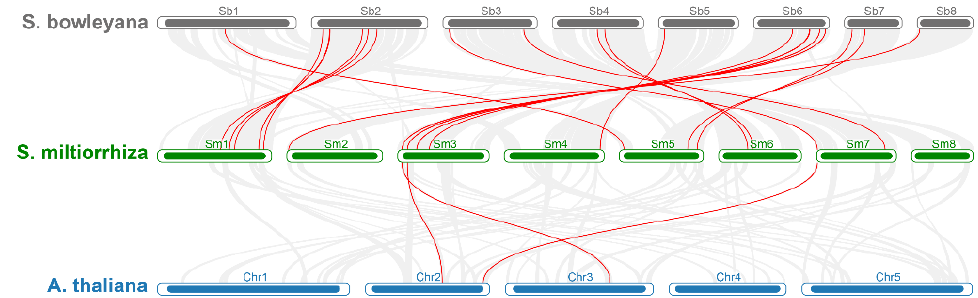
Figure 3. Synteny analysis of GATA genes within S. miltiorrhiza , A. thaliana , and S. bowleyan a. Gray lines represented all collinear blocks within S. miltiorrhiza , A. thaliana , and S. bowleyana ; the red lines showed the orthologous relationships of GATA genes between within S. miltiorrhiza , A. thaliana , and S. bowleyana